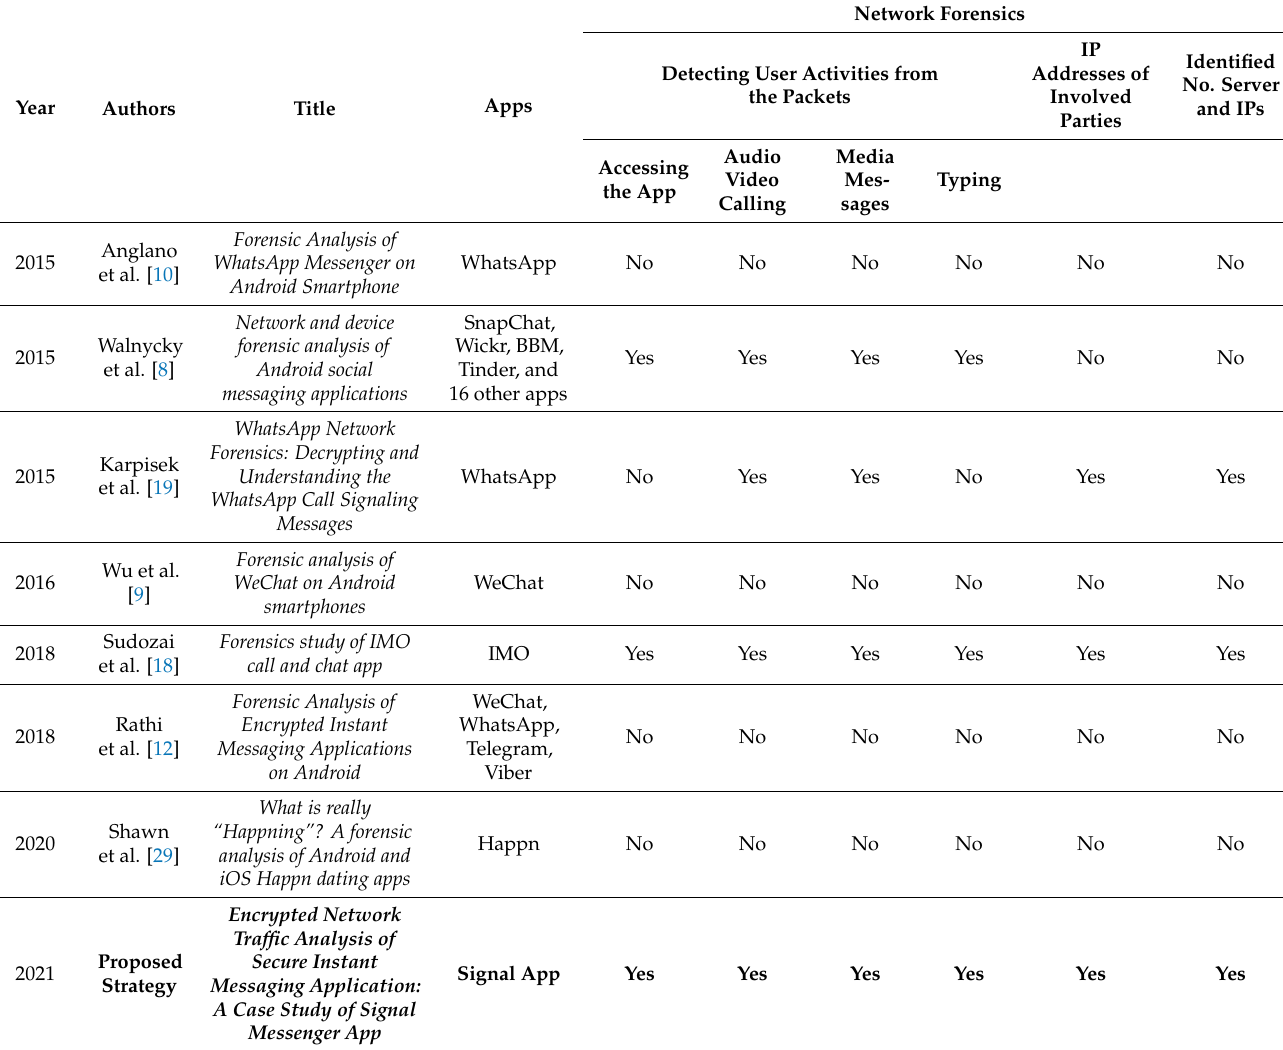
Table 5. A comparison of identified artifacts from encrypted network packets of the proposed and existing